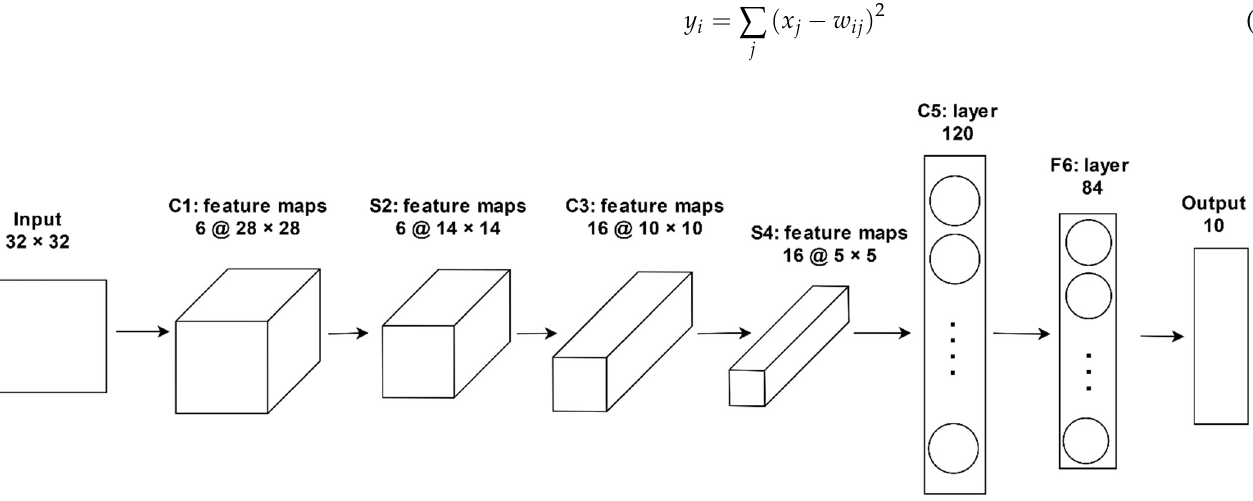
Figure 5. LeNet-5 architecture [73].